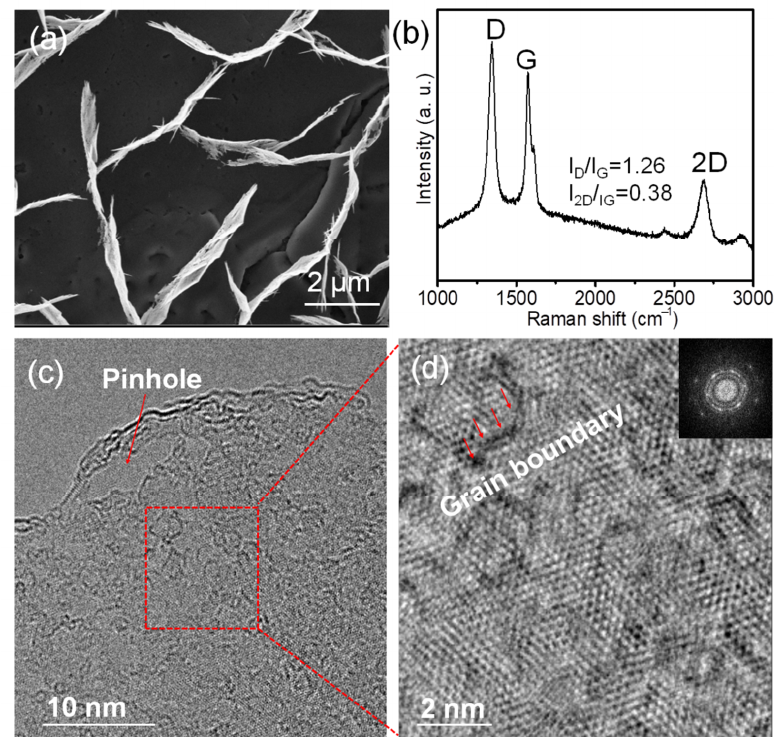
Figure 2. VFLG grown without Cu mask. ( a ) SEM image of the VFLG. ( b ) Raman spectra of the VFLG. ( c ) TEM image of the VFLG. ( d ) is magnification of the red rectangle in ( c ). Inset of ( d ) is its diffraction pattern.